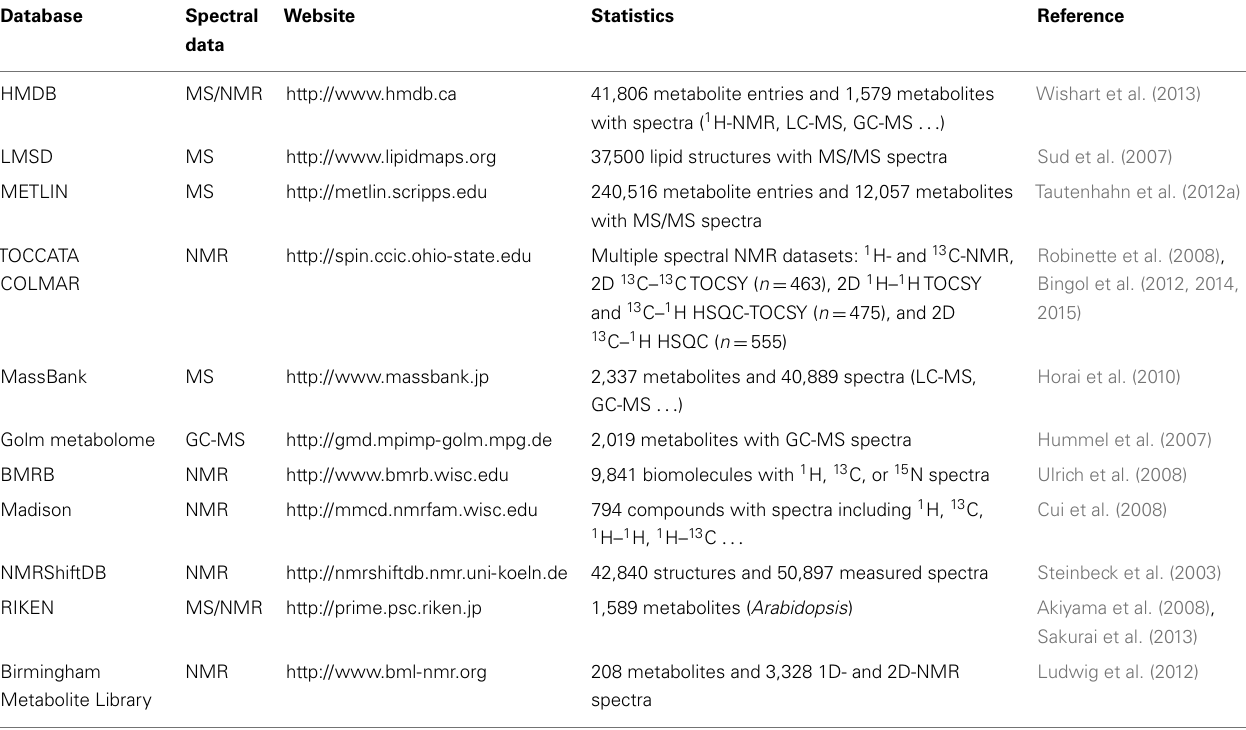
Table 2 | Spectral databases available for metabolite identification